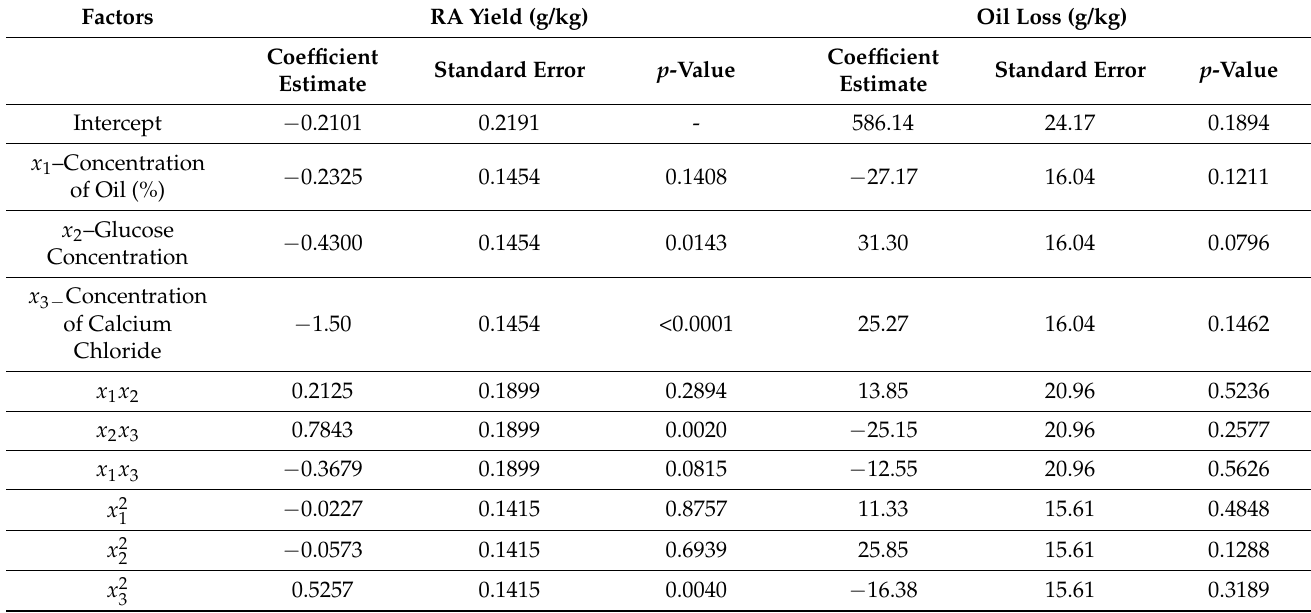
Table 5. Regression coefficients and least square fit for ricinoleic acid yield and oil